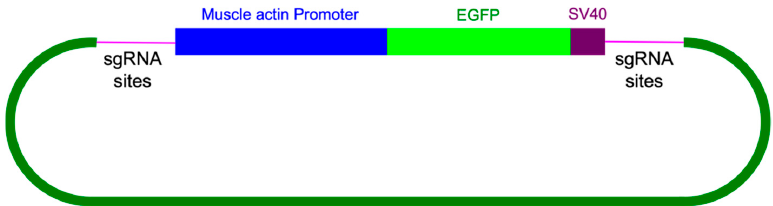
Figure 7. CRISPR knock-in construct in A. domesticus . Ad muscle actin was used to identify the promoter driving EGFP as the marker gene. Two short sequences contain the Ad vermilion sgRNA sites flanking both side of the marker gene.